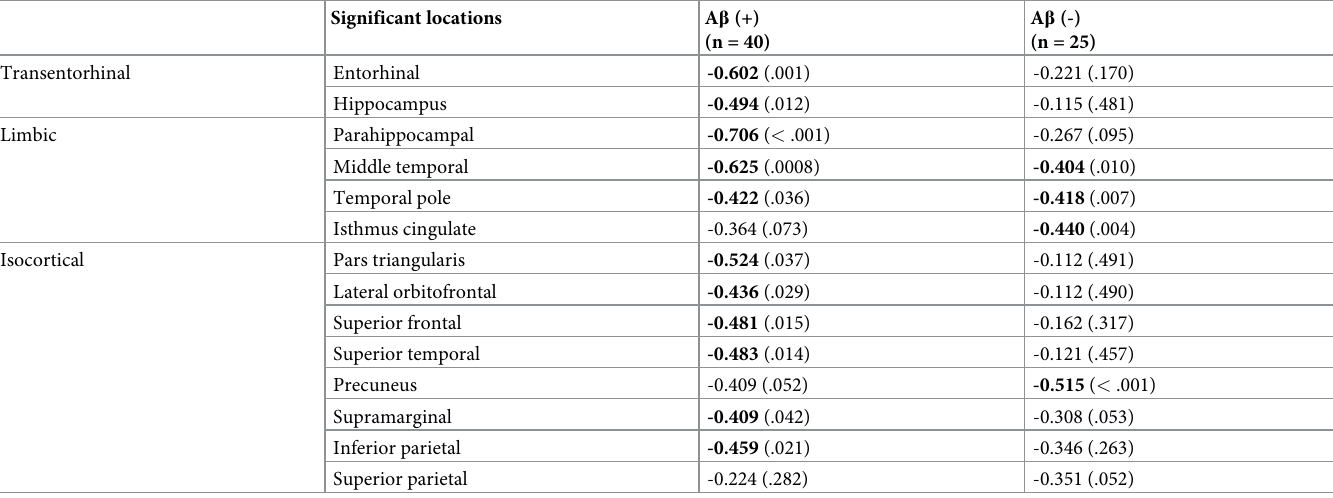
Table 3. Comparisons between β -amyloid PET-positive and PET-negative